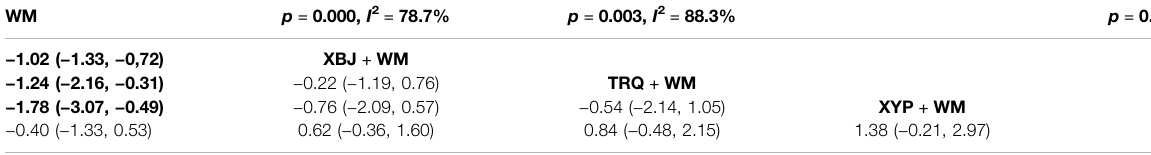
TABLE 6 | SMDs with 95% CIs of ICU length of stay. WM p = 0.000, I 2 = 78.7% p = 0.003, I 2 = 88.3% p = 0.430, I 2 = 0.0%